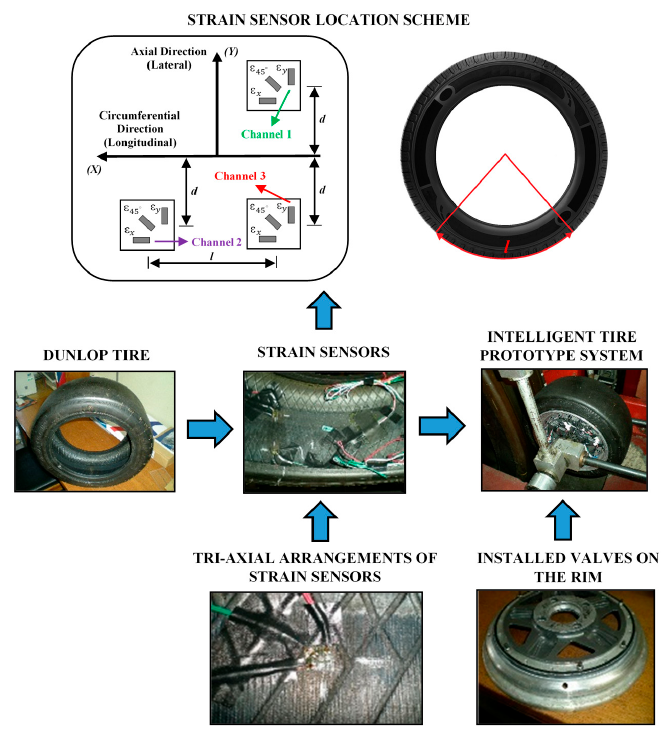
Figure 3. Strain gauges configuration.